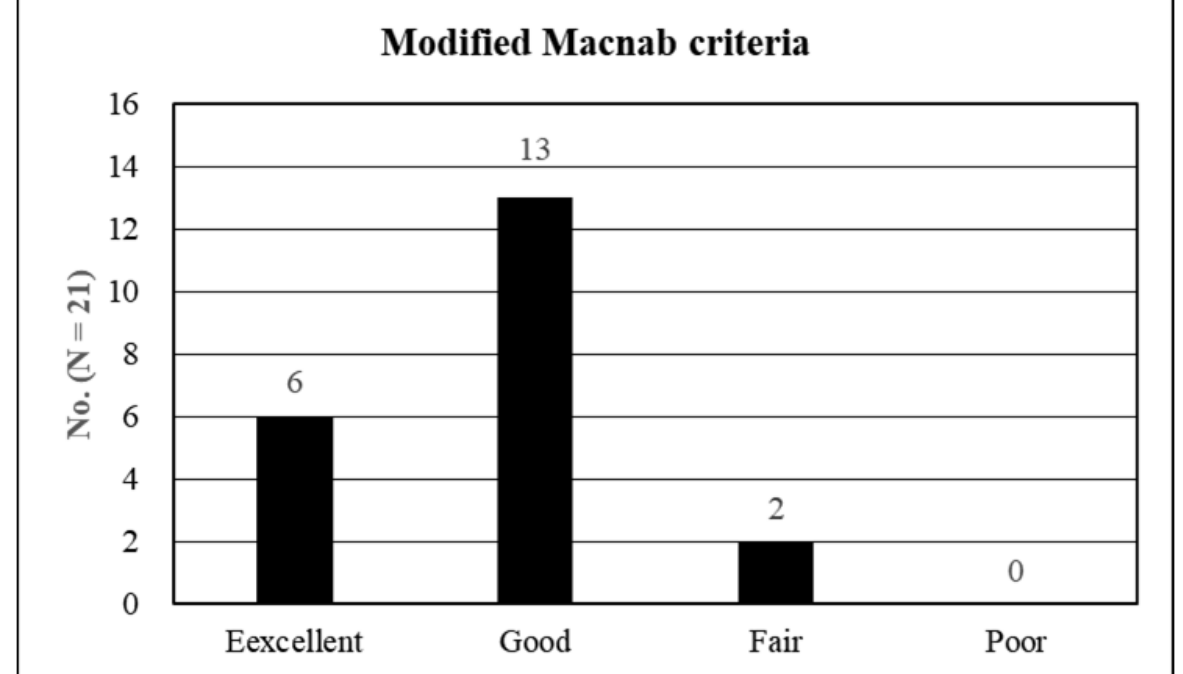
Figure 5. Clinical results. ( A ) Visual analog pain scale for radicular pain preoperatively and at 6 weeks, 6 months, 1 year, and 2 years postoperatively. ( B ) Oswestry disability index scores preoper- atively and at 6 weeks, 6 months, 1 year, and 2 years postoperatively.